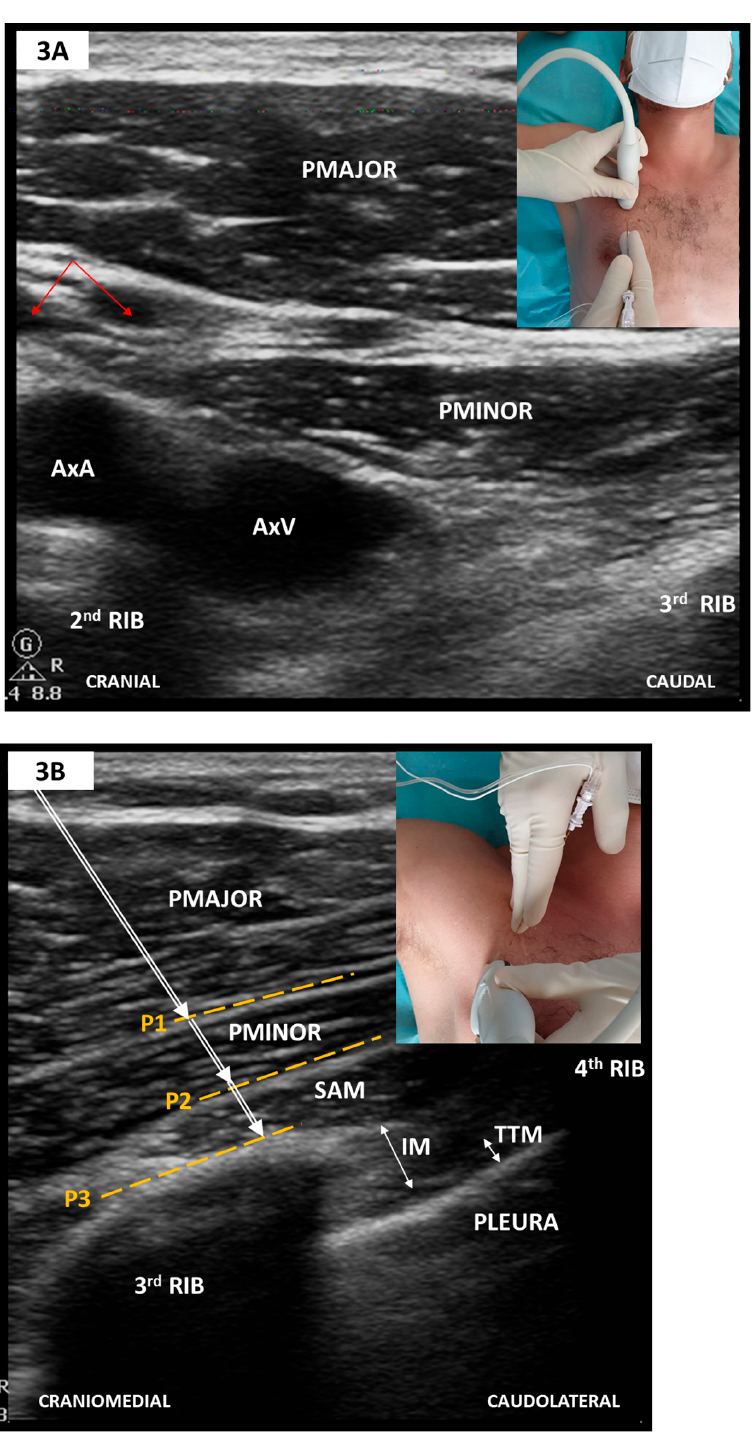
Figure 3. ( A ) . Parasagittal scan along the medioclavicular line-2nd rib level; ( B ) . Oblique scan after a slight medial tilt with inferolateral sliding towards the midaxillary line-4th rib level (see text). PMAJOR, pectoralis major muscle; PMINOR, pectoralis minor muscle; AxA, axillary artery; AxV, axillary vein; red arrows, thoracoacromial artery and vein; SAM, serratus anterior muscle; IM, intercostal muscle; TTM, transversus thoracic muscle; P1, PECS I plane; P2, superficial plane for SAPB/PECS II; P3, deep plane for SAPB/PECS II. To elicit an adequate SAPB coverage, P2 or P3 need to be targeted at the 4th or 5th rib level.